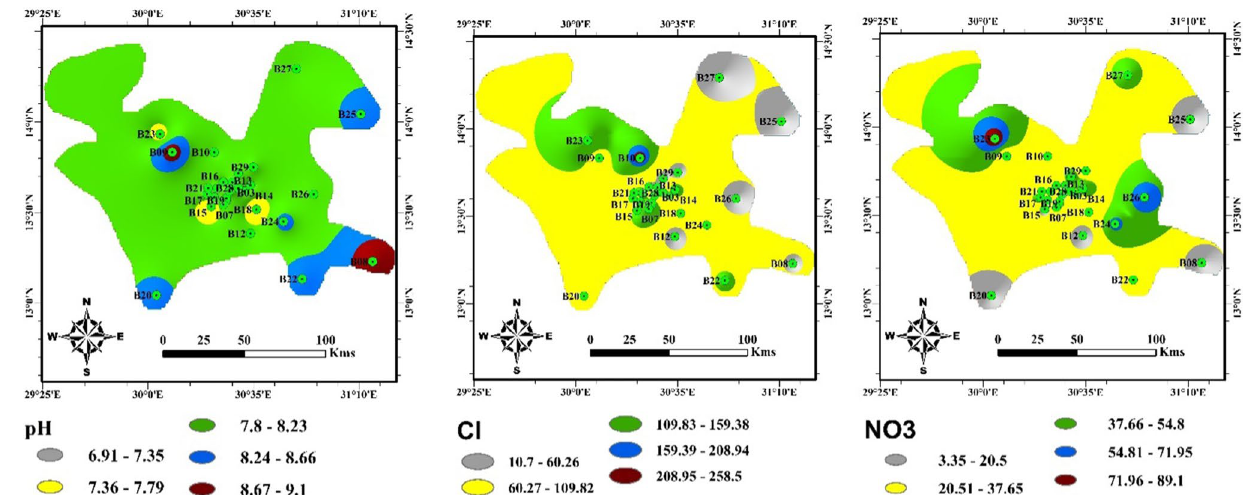
Fig. 5 Spatial distribution of GIS interpolation maps of the pH, Cl, and NO